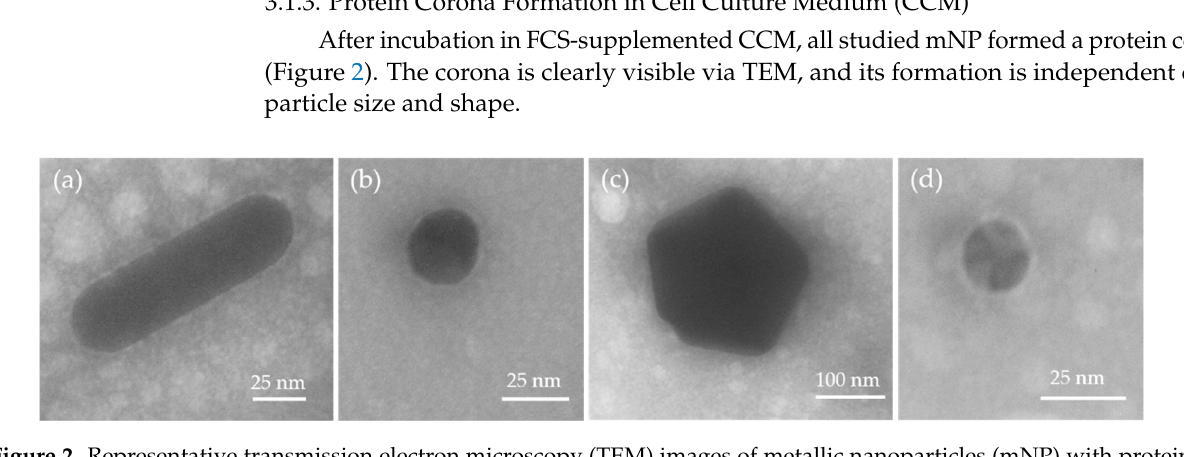
Figure 2. Representative transmission electron microscopy (TEM) images of metallic nanoparticles (mNP) with protein corona. The mNP were incubated in FCS-containing cell culture media and analyzed via TEM. ( a ) gold rods (AuNRods); ( b ) spherical 30 nm gold nanoparticles (AuNP-30); ( c ) spherical 200 nm gold nanoparticles (AuNP-200); ( d ) spherical 20 nm silver nanoparticles (AgNP).